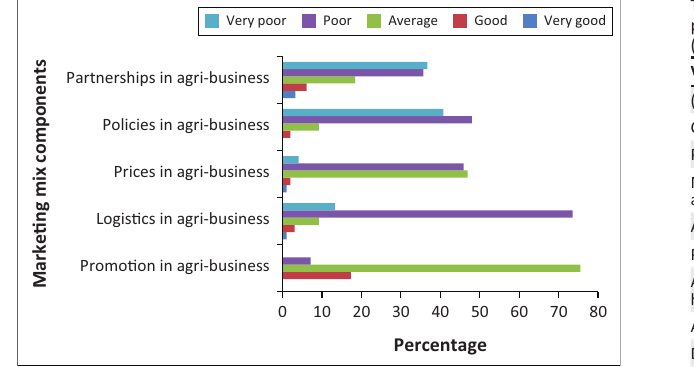
FIG URE 2: Perception of business performance in terms of the marketing mix components.